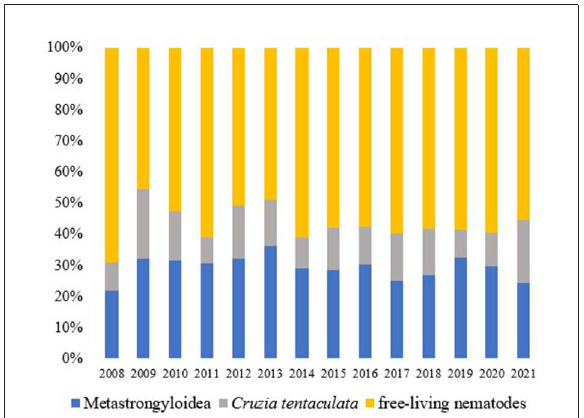
FIGURE4 Nematodes (%) observed in the terrestrial mollusks examined at the LRNEM between 2008 and